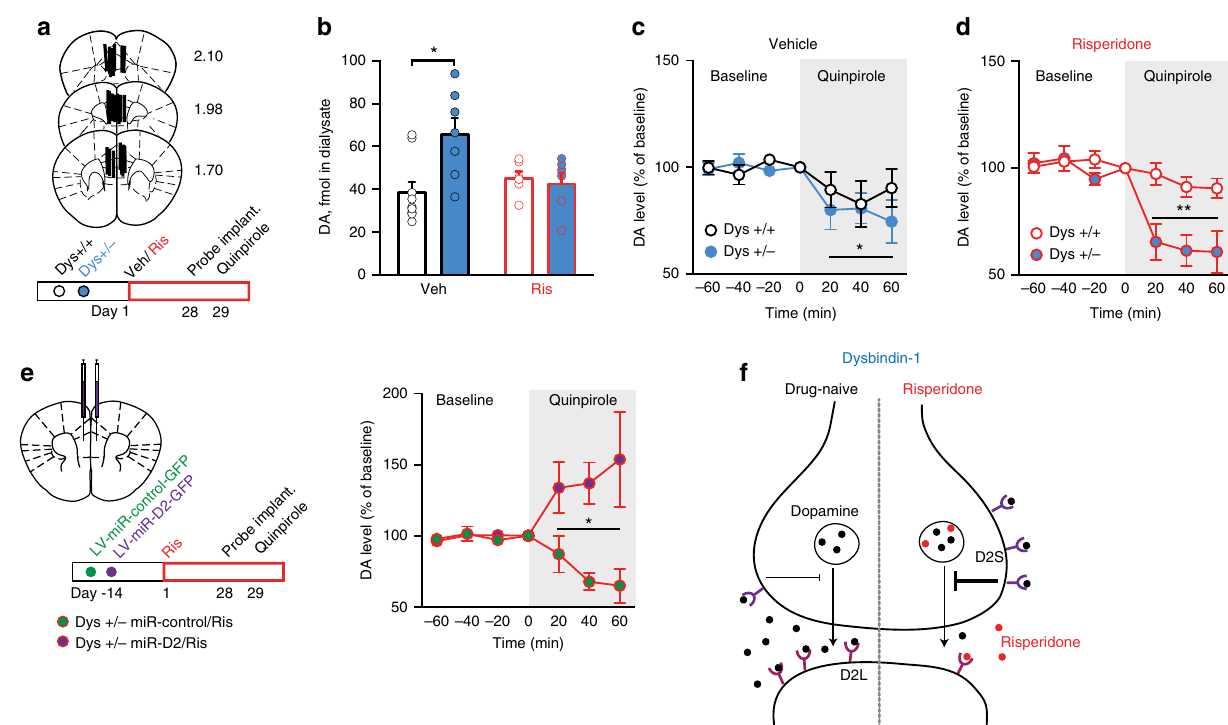
Fig. 6 Genetic variations reducing dysbindin-1 confer unique potentiation of cortical D2 autoreceptor activity following antipsychotics. a Localization of probe dialyzing portion within the mPFC and timeline of the experiment. Dys + / + and + / − mice received chronic vehicle or risperidone treatment and, after 4 weeks, were implanted with a dialysis probe for measurement of basal extracellular dopamine levels and quinpirole-induced dopamine release. b Increased basal extracellular dopamine levels in the mPFC of Dys + / − are restored by risperidone (two-way ANOVA, genotype× treatment, F = 4,61, p < 0.05; n = 6 – 7/group). p = 0.39 vs. Dys + / + . c Quinpirole infusion (gray area) equally decreased extracellular dopamine release in the (1, 27) mPFC of Dys + / + (white circles) and + / − (blue circles) mice after chronic treatment with Veh (two-way RM ANOVA, time, F (6, 60) = 2,83; p < 0.05). * p < 0.05 vs. baseline. d Dys + / − (blue circles) mice following chronic treatment with Ris (in red) showed higher ef fi cacy of mPFC quinpirole infusion (gray area) in reducing extracellular dopamine release (two-way RM ANOVA, time × genotype, F (6, 66) = 5.76, p < 0.0005). Quinpirole had no effect on risperidone-treated + / + mice (white circles; p = 0.38 vs. baseline). ** p < 0.005 vs. Dys + / + . e Dys + / − mice received a synthetic microRNA (miR)